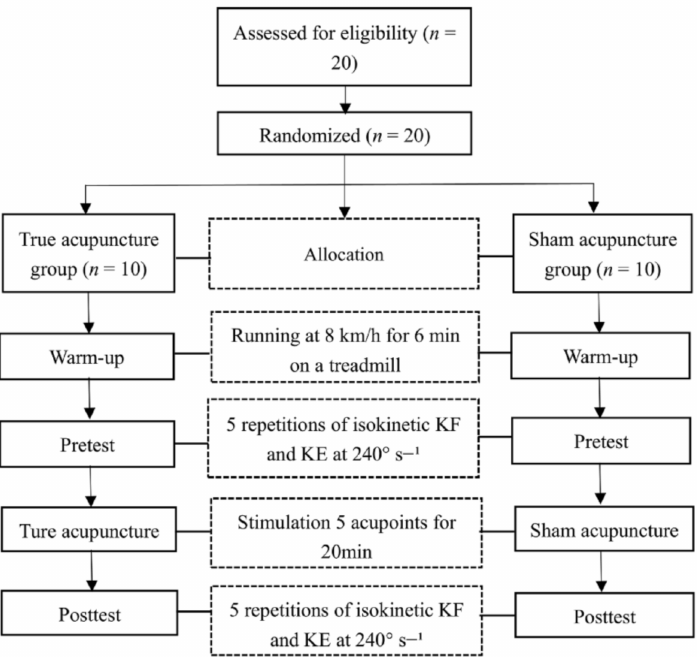
Figure 1. Flow diagram for the study. KF = knee flexion; KE = knee